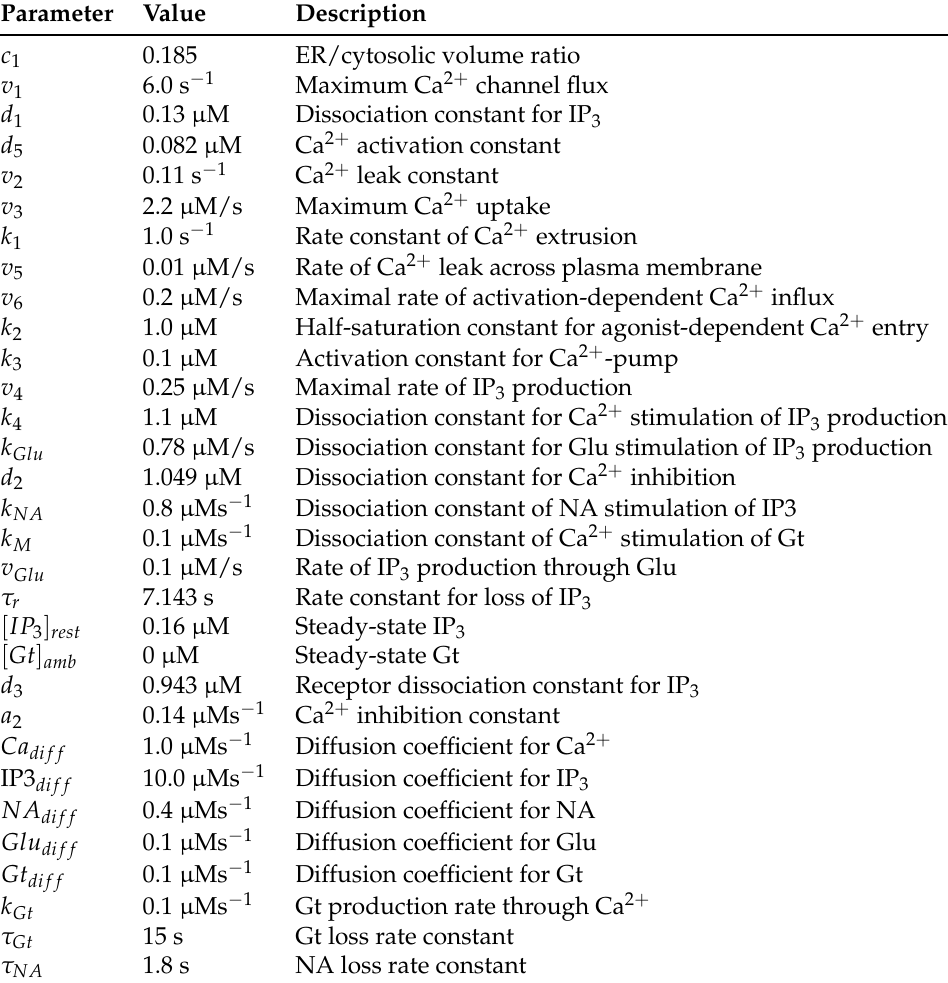
Table 2. Basic set of model